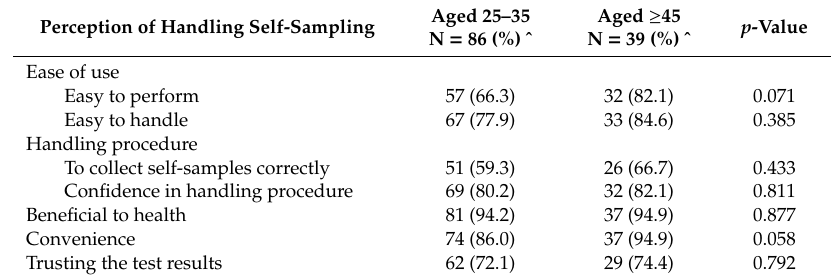
Table 3. Comparison of perception on handling HPV self-sampling between the two age groups.